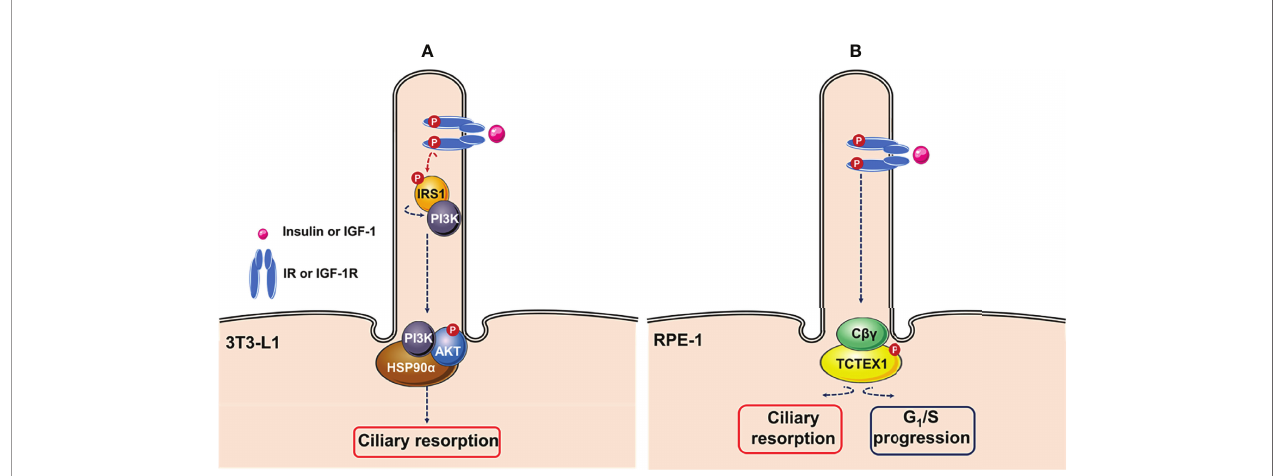
FIGURE 3 | Ciliary insulin/IGF-1 signaling pathways. (A) Insulin stimulates resorption of cilia mouse in 3T3-L1 cells through activation of IGF-1R via recruitment of IRS1. Activated IRS1 is re-localized to the ciliary neck region, where heat shock protein Hsp90 a might functions as a hub for activation of AKT. (B) Ciliary insulin growth factor-1 receptor (IGF-1R) activation induces ciliary resorption and G1/S progression via IGF-1-mediated recruitment of phosphorylated Tctex-type 1 (TCTEX- 1) via non-canonical G-protein signaling (C bg ) in RPE-1 cells. This fi gure was created using Servier Medical Art (available at